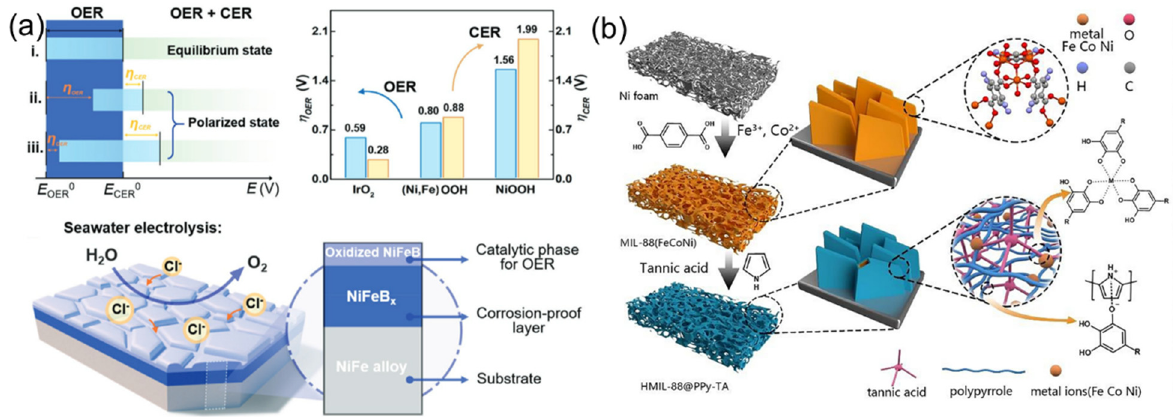
Figure 13. ( a ) Schematic diagram of the multilayer oxidized NiFeB/NiFeB x /NiFe alloy [61]; ( b ) Preparation schematic of HMIL-88@PPy-TA catalyst [62].